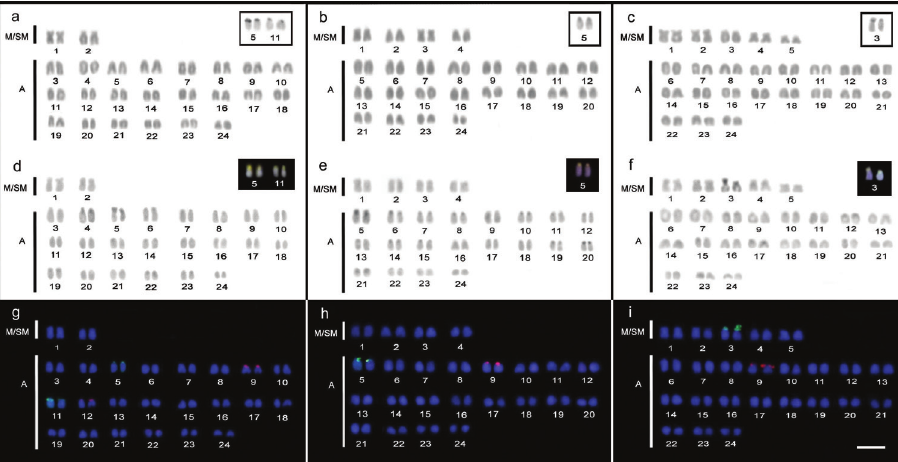
Figure 1. Karyotypes of Trachinotus goodei ( a, d, g ), T. carolinus ( b, e, h ) and T. falcatus ( c, f, i ) . Conven- tional staining ( a, b, c ) highlighting the chromosomal pairs carrying Ag-NOR sites; C-banding ( d, e, f ); nucleolar organizer pairs are highlighted by staining with CMA 3+ /DAPI - . Dual-color FISH ( f, g, h ) show- ing the chromosomal mapping of the 18S rDNA (green) and 5S rDNA (red) sites. Bar = 5